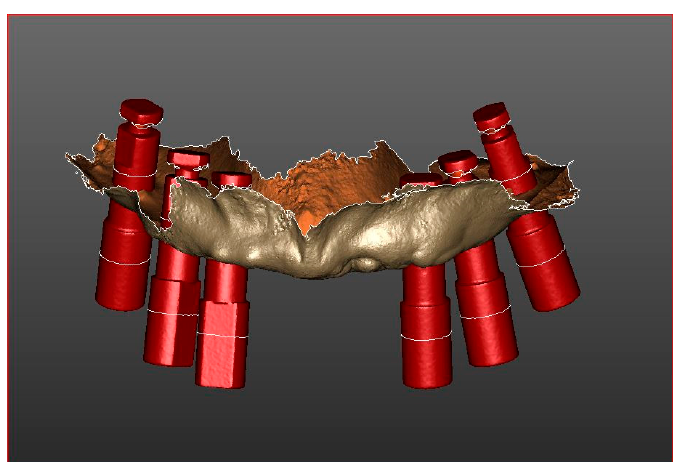
Figure 3. Matching of soft tissues, scan bodies and virtual models of related components scans.